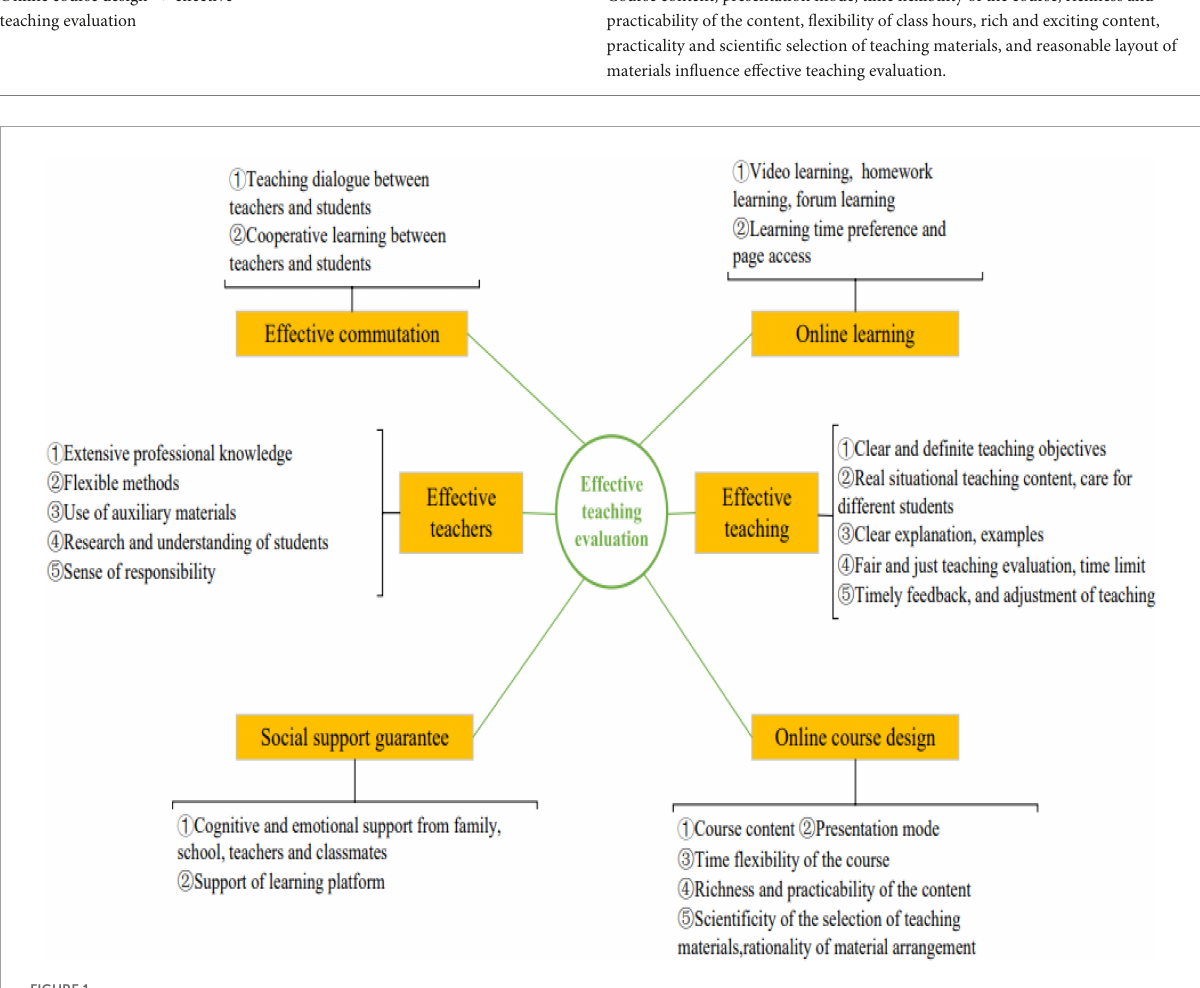
FIGURE1 Students’ massively open online courses (MOOCs) learning behavior and effective teaching evaluation